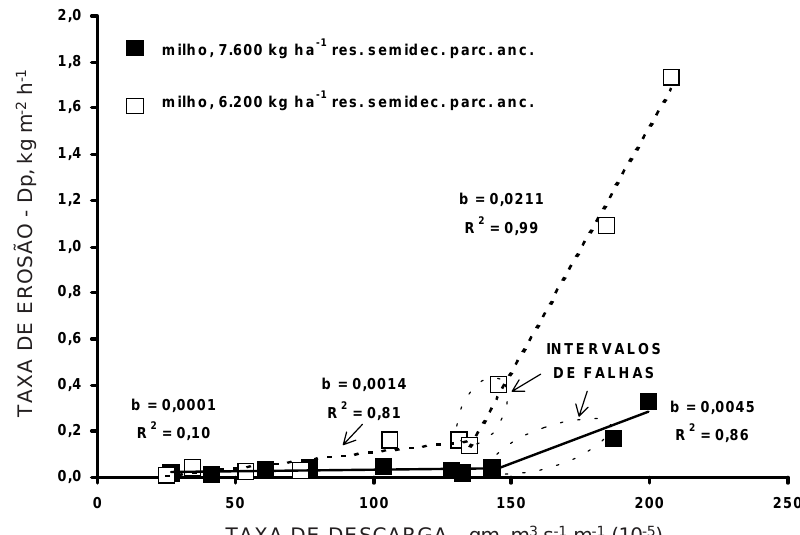
Figura 1. Relação da taxa média de erosão, Dp, com a taxa de descarga no ponto médio da parcela, qm, nos tratamentos com 7.600 e 6.200 kg ha -1 de resíduos de milho, semidecompostos e parcialmente ancorados, no sistema de semeadura direta (Experimento